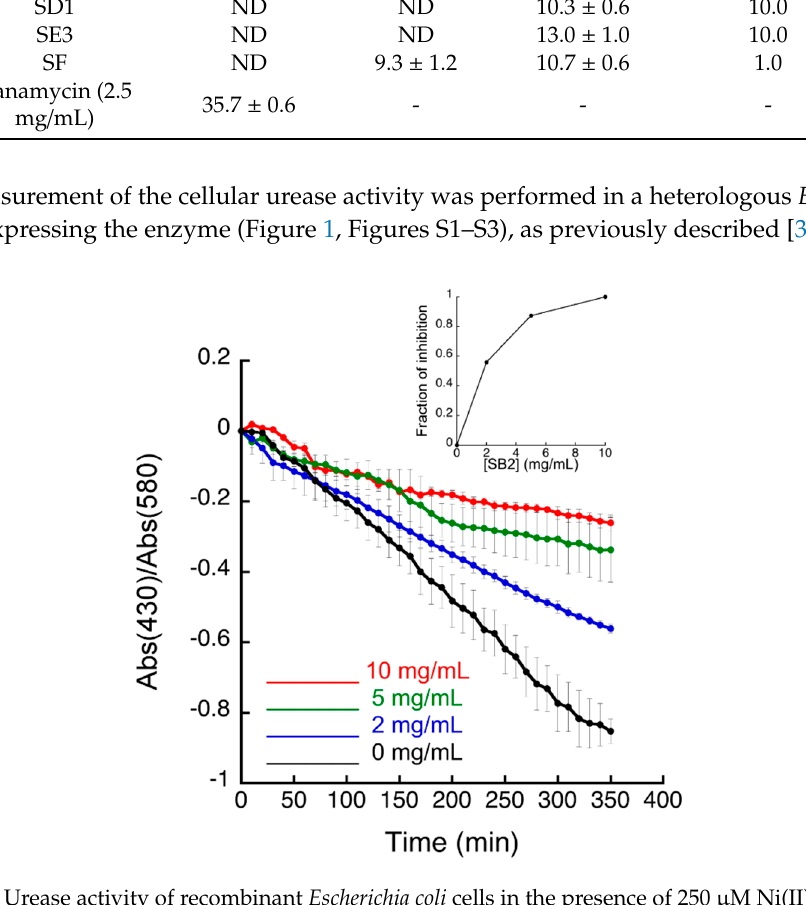
Figure 1. Urease activity of recombinant Escherichia coli cells in the presence of 250 µ M Ni(II) and of 80 mM urea, measured as a change of pH detected by the cresol red indicator. Increasing concentrations of the sub-fraction SB2 were added to the E. coli culture before performing the colorimetric assay. Data are shown as mean ± SD of the triplicates. The insert represents the dose-response plot for the SB2 sub-fraction. Sub-fraction SB2 (90% Cyhex / EtOAc) was obtained from fraction B.